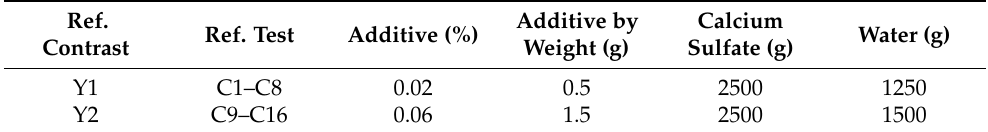
Table 6. Quantity of dosages of the different materials used in the mixture.